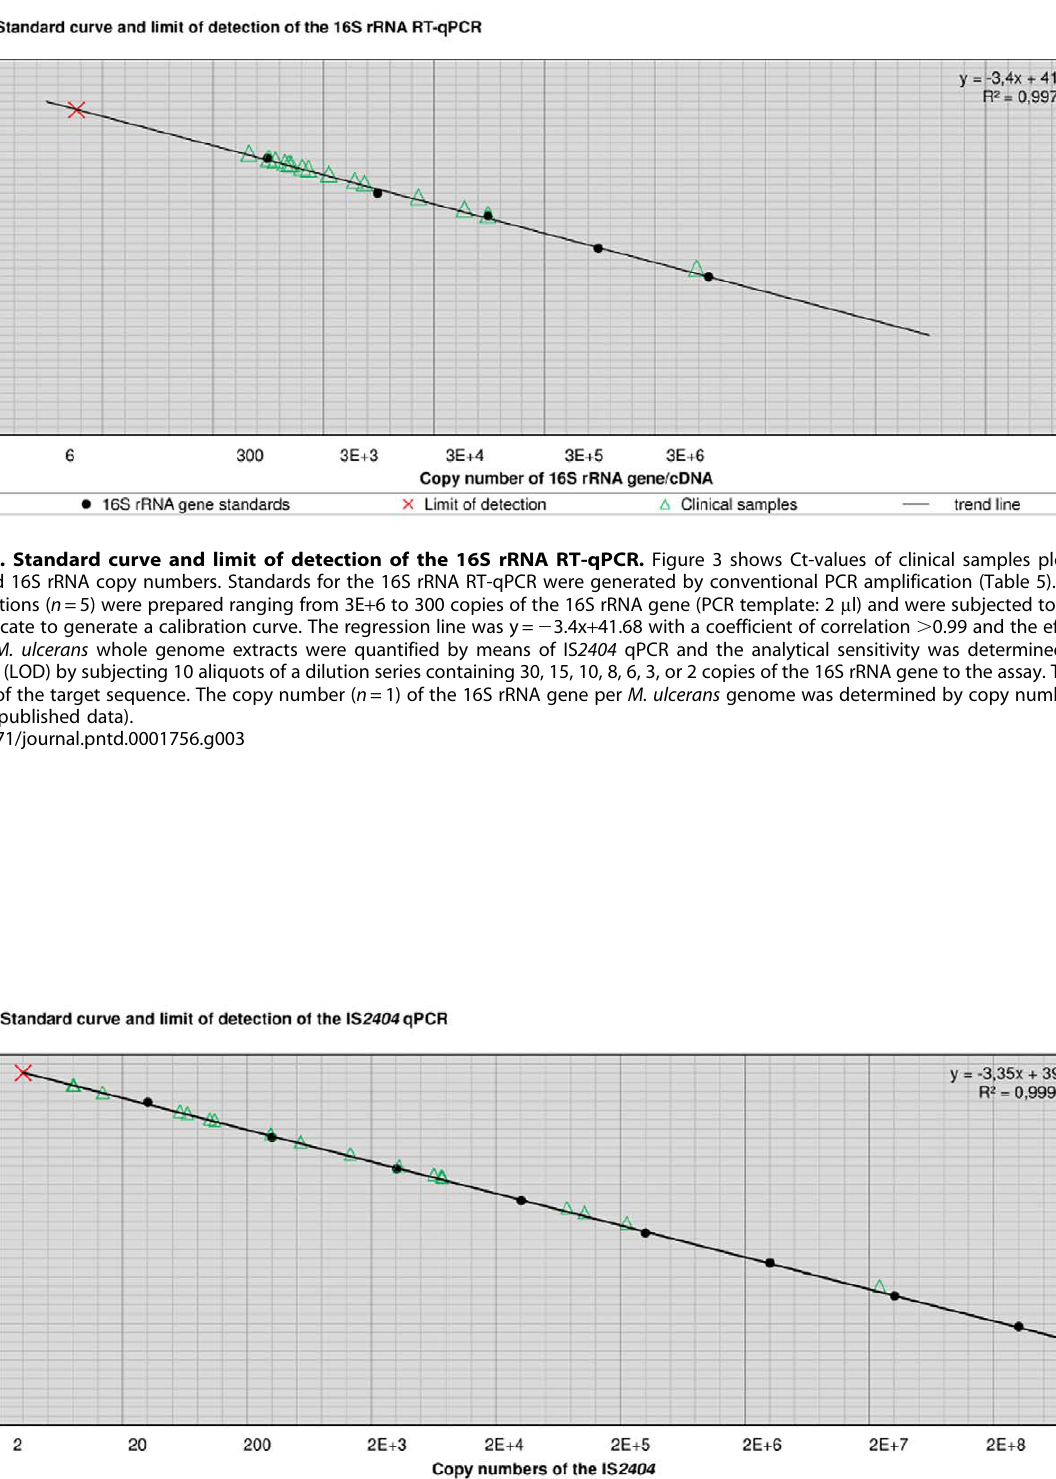
PLOS Neglected Tropical Diseases |